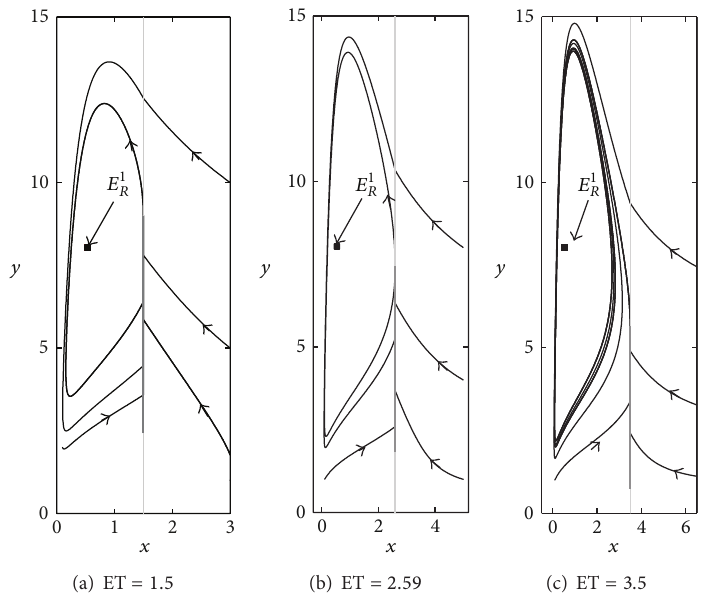
Figure 5: Globally touching bifurcation for Filippov system (3). The parameter values are fixed as follows: 𝑎 = 0.51 , 𝑏 = 0.4 , 𝑟 = 1.2 , 𝑘 = 6 , = 0.4 , and 𝑞 = 0.1 𝛽 = 0.6863 , 𝛿 = 0.05 , 𝑞 1 2